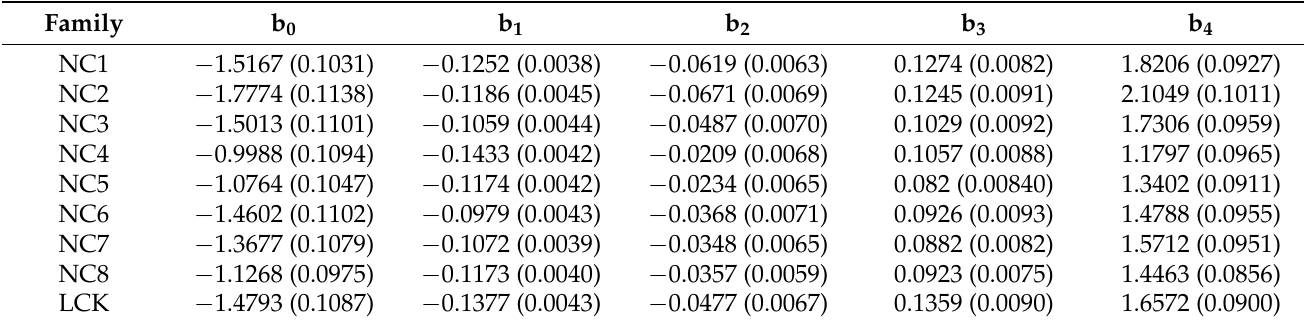
Table 7. Parameter estimates and their standard errors (in parenthesis) for family-specific beta regression models for predicting live crown ratio of loblolly